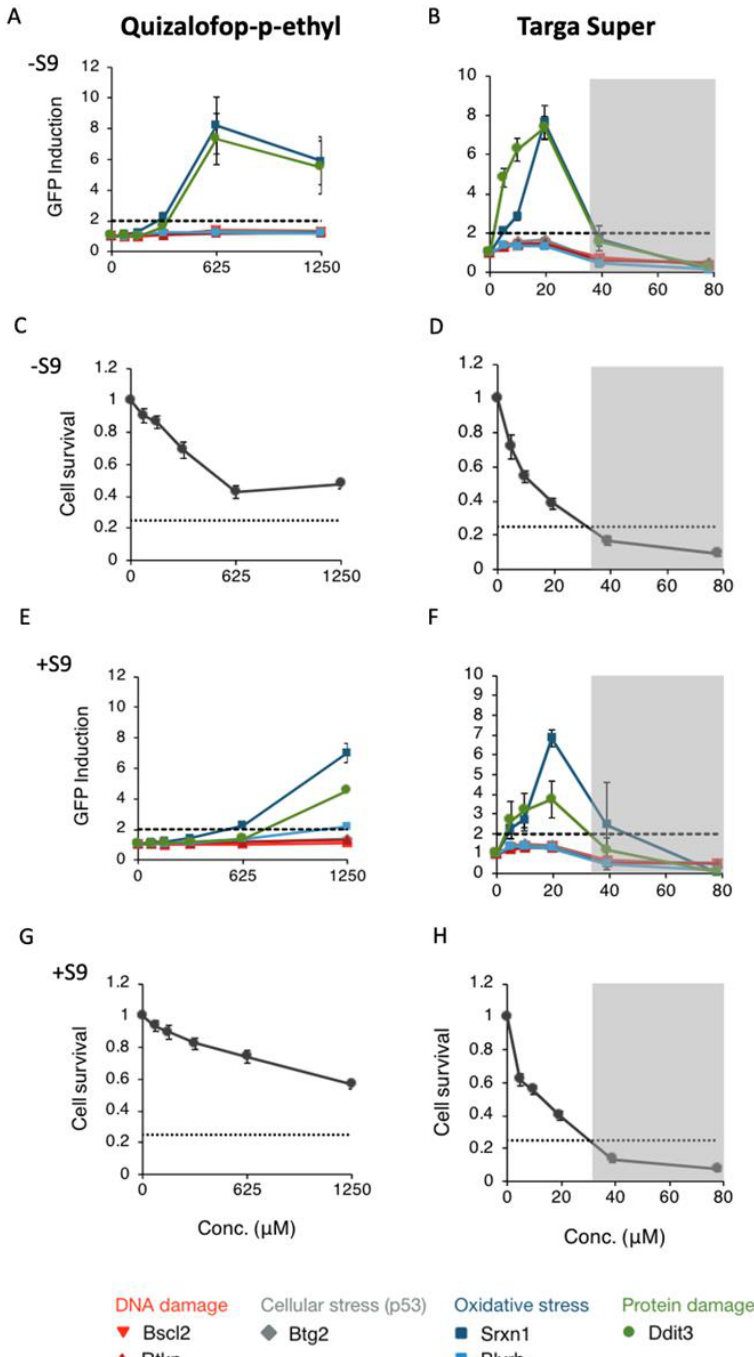
Figure 5. Activation of mechanisms known to be key characteristics of carcinogens by quizalofop-p-ethyl and Targa Super utilising the ToxTracker assay system. The six mES reporter cell lines that comprise the ToxTracker assay system were used to detect the activation of a DNA damage response (Bscl2 and Rtkn), oxidative stress (Srxn1 and Blvrb), protein damage and an unfolded protein response (Ddit3), and p53-mediated cellular stress (Btg2). Showing the induction of reporter gene expression in absence of S9 metabolising liver extract ( A , B ) and associated changes in cell survival ( C , D ). Induction of reporter gene expression in the presence of S9 liver extract ( E , F ) and cell survival ( G , H ). Grey box covers measurements with less than 25% cell survival and were not taken into consideration due to too high cytotoxicity. Dotted line is the threshold for a positive ToxTracker